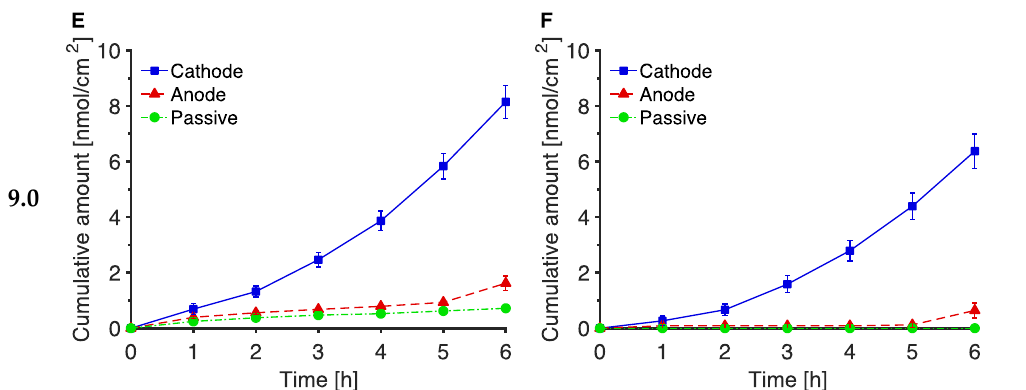
Figure 2. Cumulative amounts of Trp ( A , C , and E ) and Kyn ( B , C , and F ) extracted passively and by reverse iontophoresis as a function of time at three different receptor solution pH values: pH 4.0 ( A , B ), pH 7.4 ( C , D ), and pH 9.0 ( E , F ). The data points show the mean ± SEM ( n = 4–12, see Table 2). At pH 7.4 (i.e., when there is no pH gradient across the skin), the passive extraction of